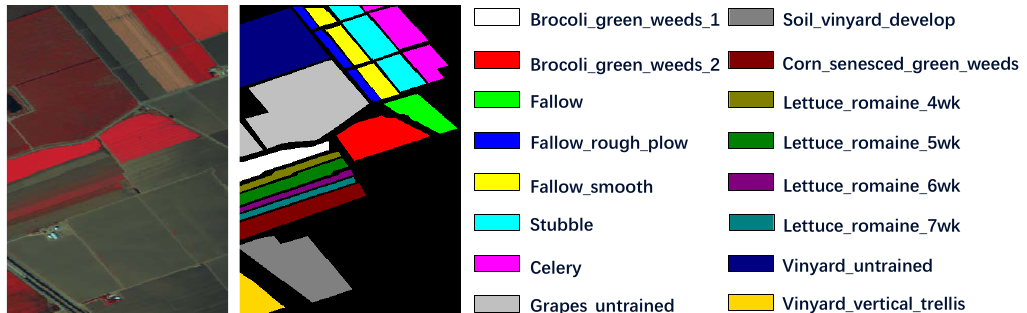
Figure 3. Salinas dataset description. The false-color image is generated from spectral band 52, 25, 10 and the groundtruth map together with the respective classes are displayed.